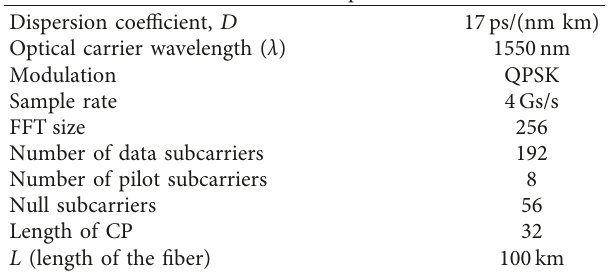
Table 1: Simulation